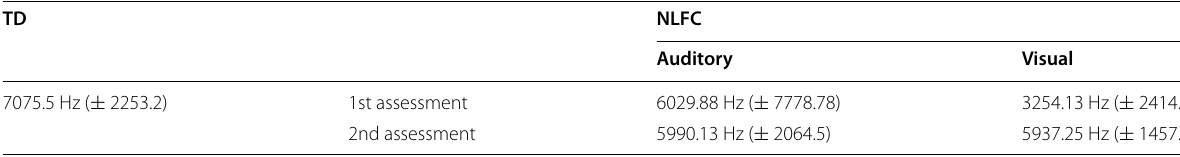
Table 5 Mean of F2 onset in /sa/ syllable in TD and NLFC groups